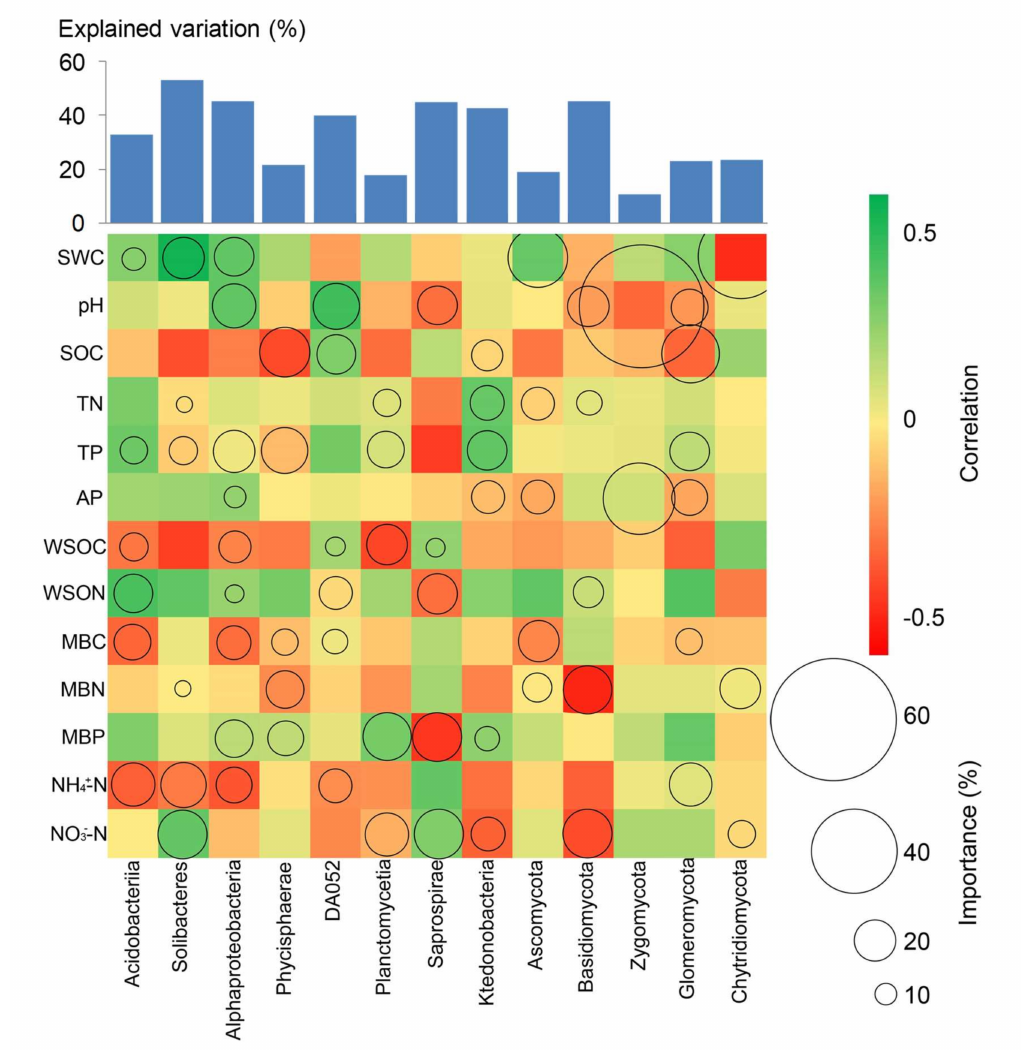
Figure 4. Contributions of soil properties to the dissimilarities in microbial communities and di ff erences intherelativeabundancesofmicrobialphylabasedoncorrelationandthebestmultipleregressionmodel. The correlation of the values with the di ff erences in soil properties between bacteria and fungi for each pairwise set of soil samples was examined, and the major predictors were identified. Circle size represents the variable importance. The proportion of explained variability calculated via multiple regression modeling and variance decomposition analysis. Colors represent the Spearman